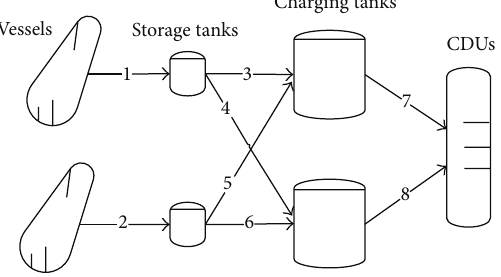
Figure 1: Crude oil operations system for the problem.